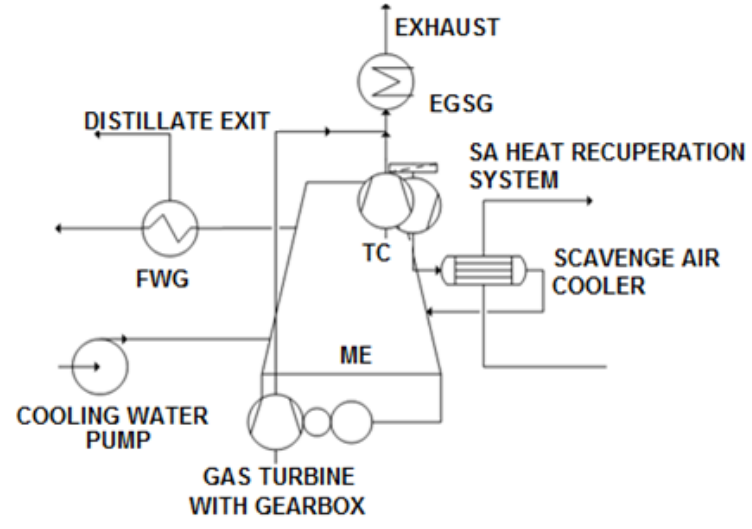
Fig. 4. Main engine waste heat